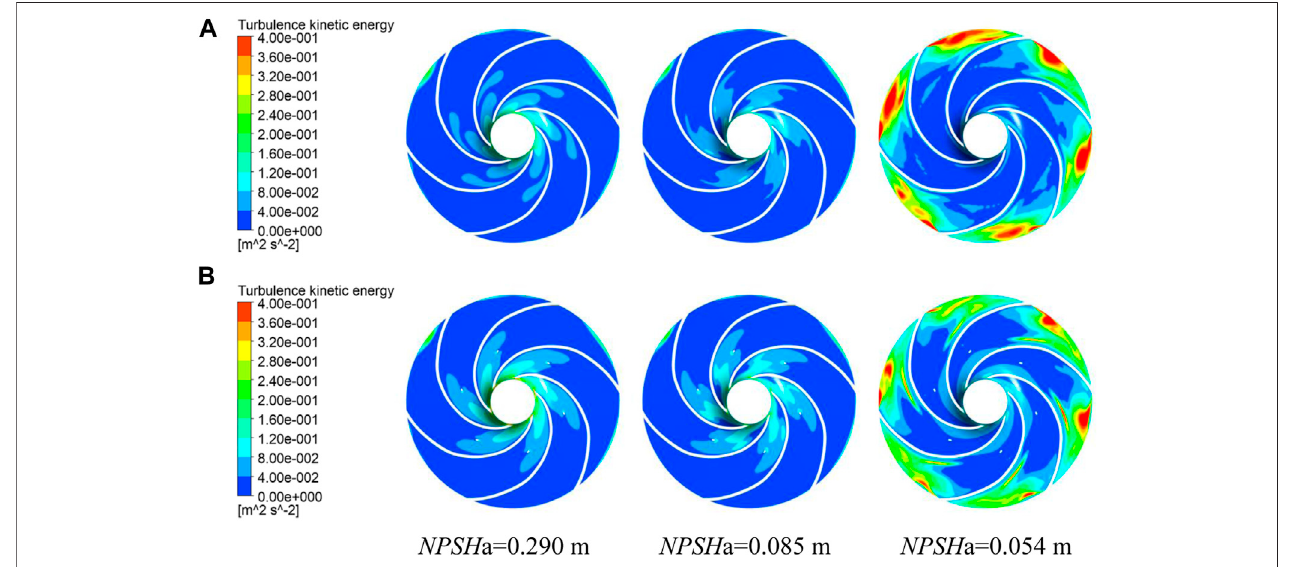
FIGURE 11 | Turbulent kinetic energy distribution in the middle section of the impeller: (A) original impeller and (B) B3 impeller.